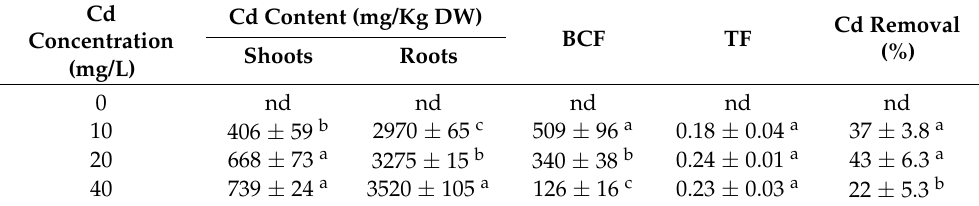
Table 2. Cd content in shoots and roots of T. latifolia plants exposed to Cd for 10 days.